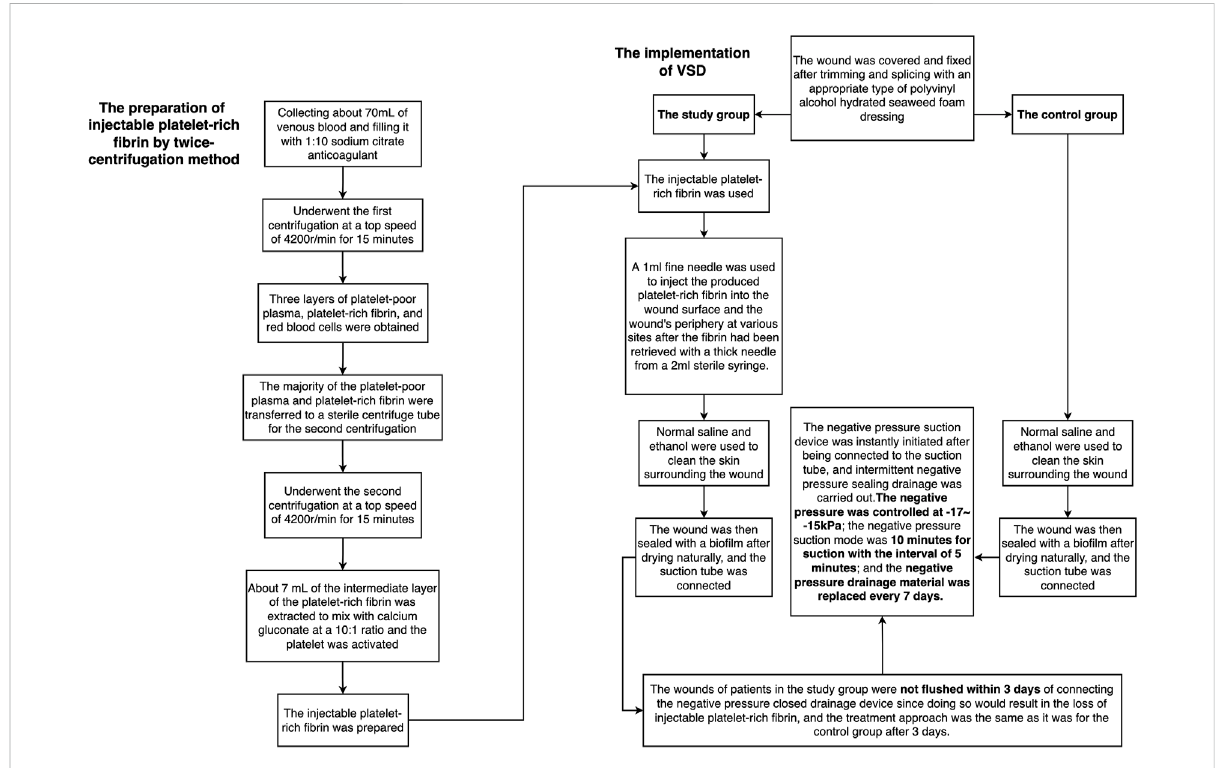
FIGURE 2 The fl ow chart of the preparation of injectable platelet-rich fi brin by a twice-centrifugation method and the implementation of